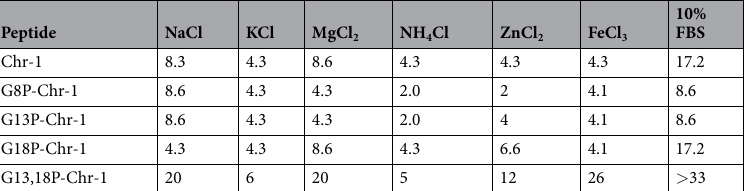
Table 4. Antibacterial activity of Chr-1 and its variants (in μ M) in the presence of different salts at their physiological concentrations against E. coli ATCC 25922. The final concentrations of NaCl, KCl, NH 4 Cl, MgCl 2 ,